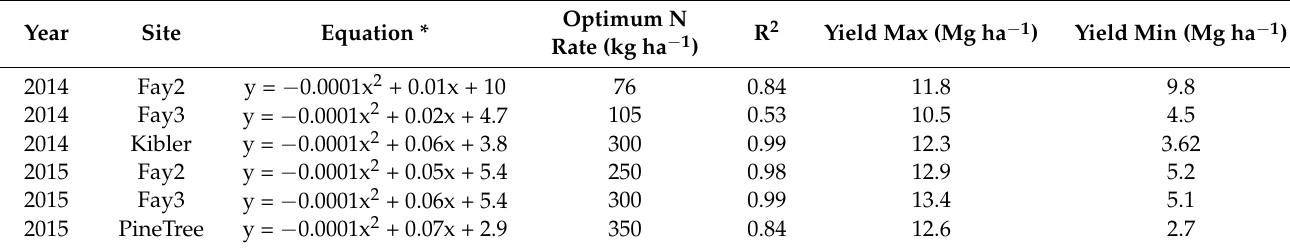
Table 4. Relationship between corn yield and N inputs.